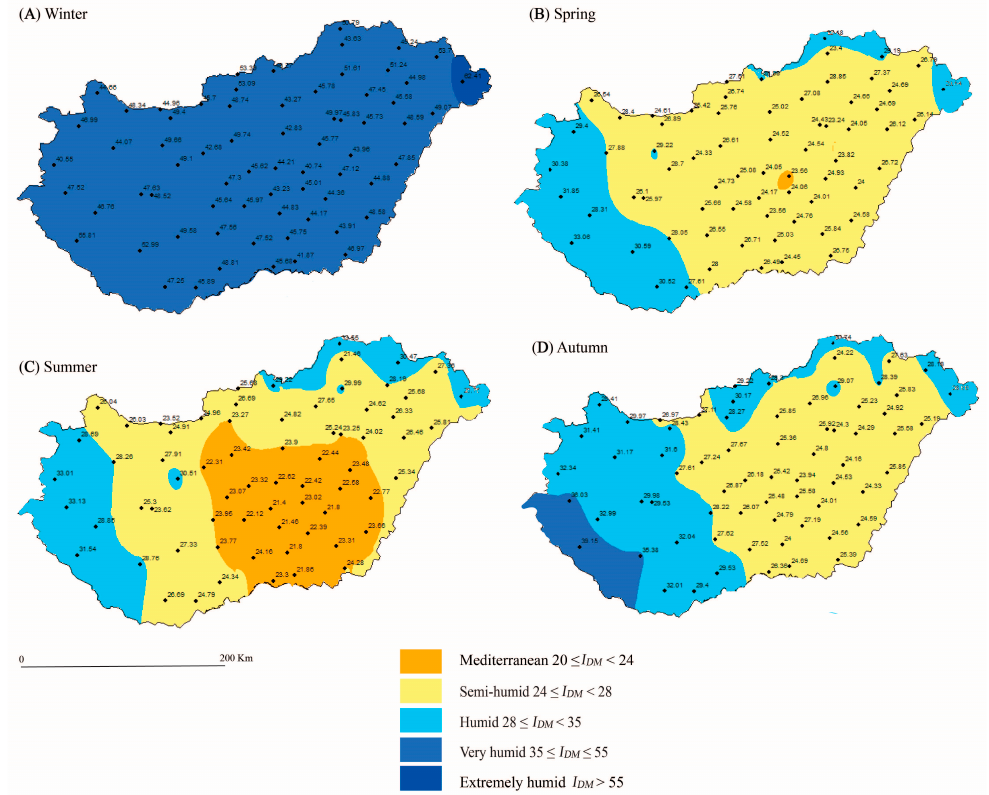
Figure 3. The spatial distribution of the seasonal De Martonne Aridity Index for Hungary during the period 1931–2017; ( A ) winter, ( B ) spring ( C ) summer, and ( D ) autumn.